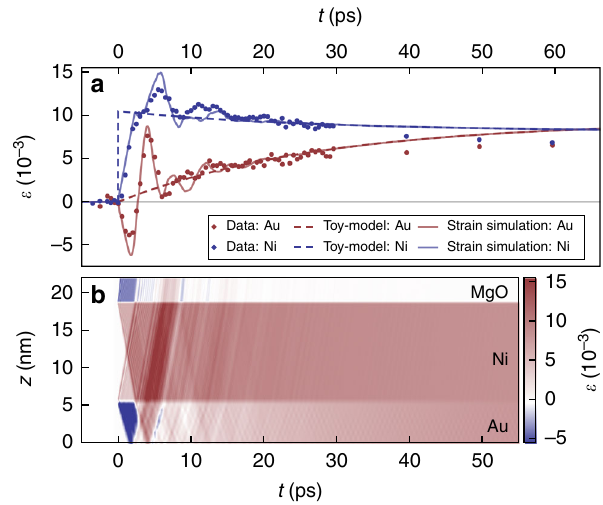
Fig. 4 Comparison of models with the experimental data. a Dots indicate the measured strain ε . The dashed lines represent the strain calculated from the average heating of the layers according to the model visualized in Fig. 1b. Solid lines are simulations, which are based on this model and additionally include the strain waves triggered by the impulsive excitation (see Methods section). Heat transport to the substrate is not included. b Color-coded strain ε as a function of sample depth and time t , which is simulated assuming a spatially homogeneous transient thermal stress in each layer which is proportional to the dashed lines in ( a ). Spatial averaging of the strain ε ( t ) in each layer yields the solid lines in panel ( a